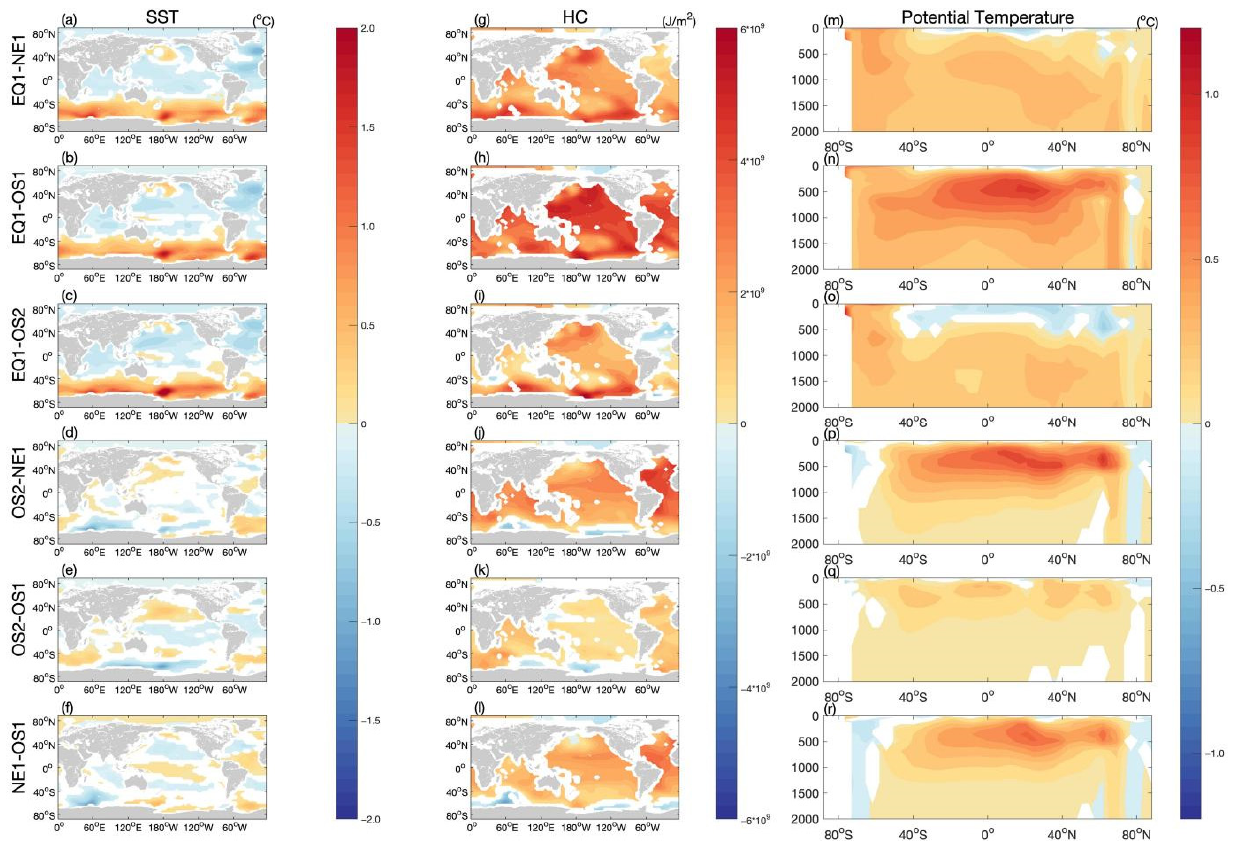
Figure 5. The differences in SST ( a – f ), HC ( g – l ), and potential temperature ( m – r ) between equilibrium experiment and other three 1.5 °C situations (NE, OS1, OS2). The units are °C, J/m 2 , and °C for three columns.